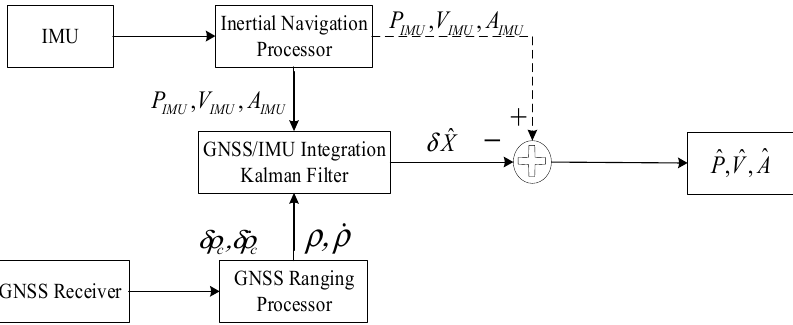
Figure 1. Tightly coupled inertial measurement unit (IMU)/global navigation satellite system (GNSS) integration architecture.